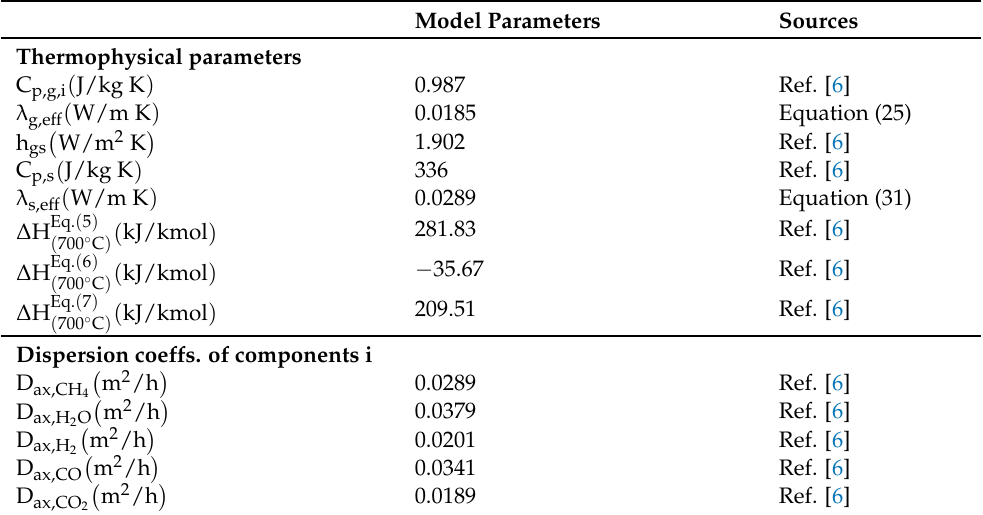
Table 4. Numerical values of thermophysical parameters and dispersion coefficients of chemical components for simulating the SRM method in